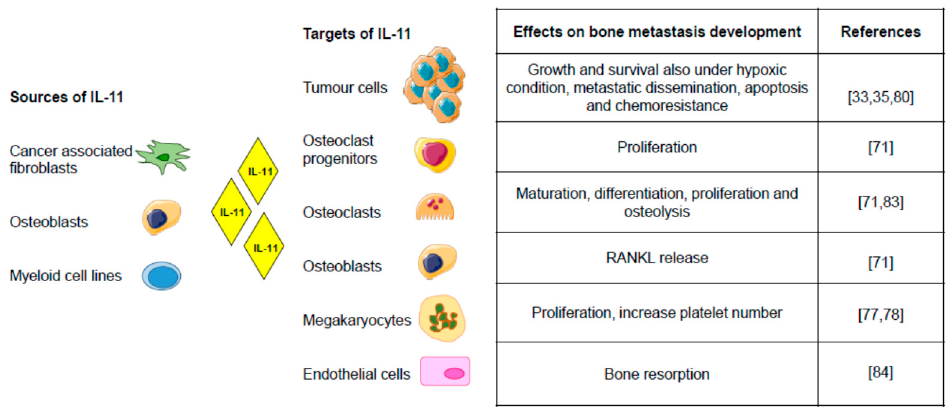
Figure 2. Sources, targets, and effects of IL-11 in bone metastasis [33,35,71,78,80,83,84]. IL-11 provides the cells a path to communicate with each other. It acts in paracrine as well as autocrine ways, contributing to the complexity of bone metastatic microenvironment (Figure created using Servier Medical Art available at https://smart.servier.com, accessed on 7 May 2021).